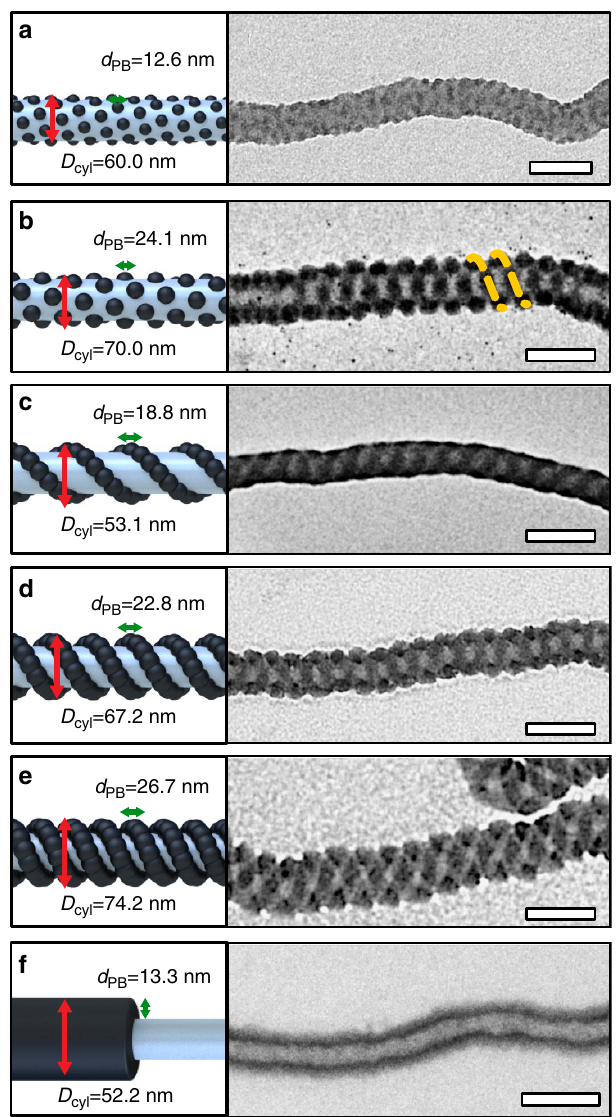
Figure 3 | Cylinder micelles with controlled patch morphology. ( a ) Small PB spheres of S 540 B 173 T 137 in acetone/isopropanol (60:40v/v) and ( b ) large PB spheres of S 510 B 539 T 154 in acetone/isopropanol (85:15v/v). ( c – e ) S 510 B 539 T 154 form thin, S 307 B 385 T 81 medium and S 307 B 530 T 75 thick PB double helices all in acetone/isopropanol (60:40v/v). ( f )